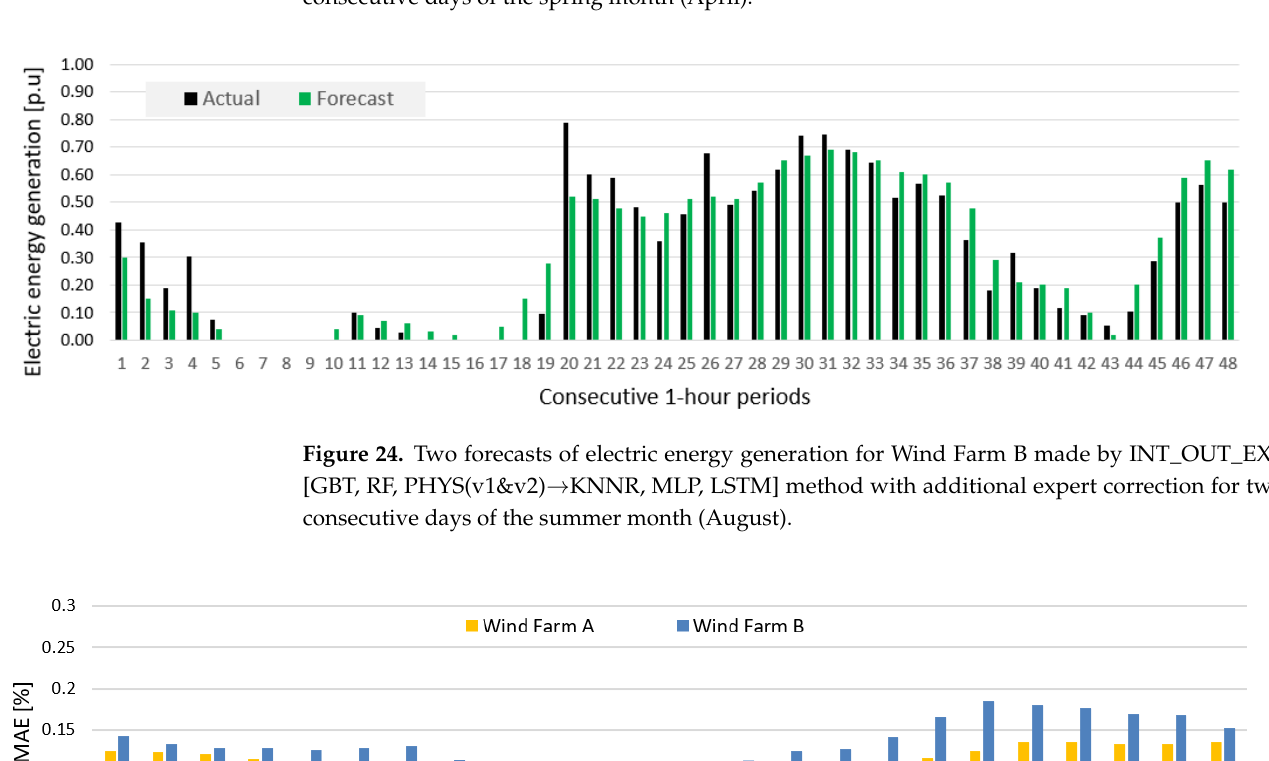
Figure 24. Two forecasts of electric energy generation for Wind Farm B made by INT_OUT_EXT